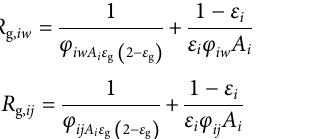
Frontiers in Energy Research |